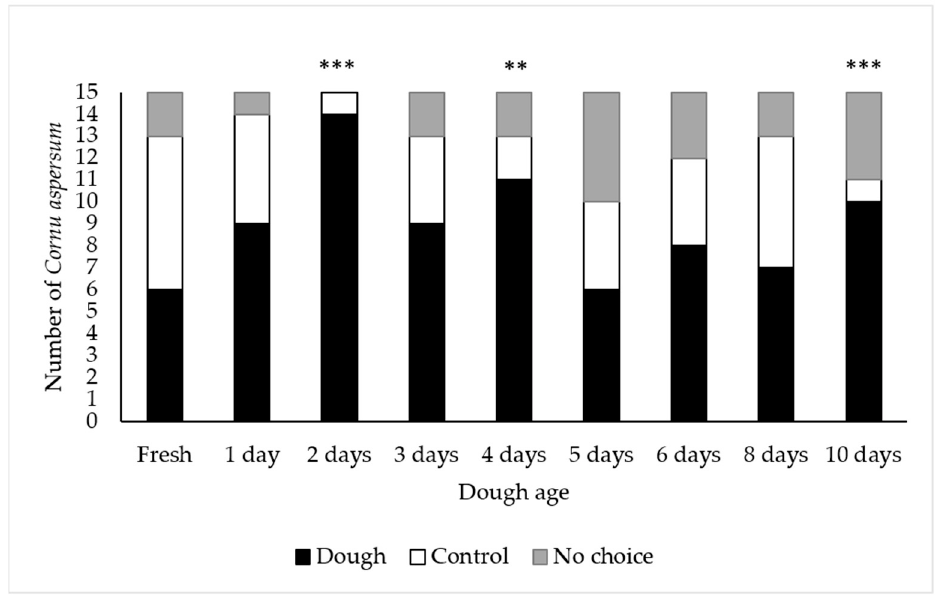
Figure 1. Number of Cornu aspersum that selected bread dough, the water control, or that made no choice in laboratory choice tests. Bars with asterisks indicate a significant difference in the number of snails that chose the bread dough versus water control (** = p < 0.01; *** = p < 0.001). Chi